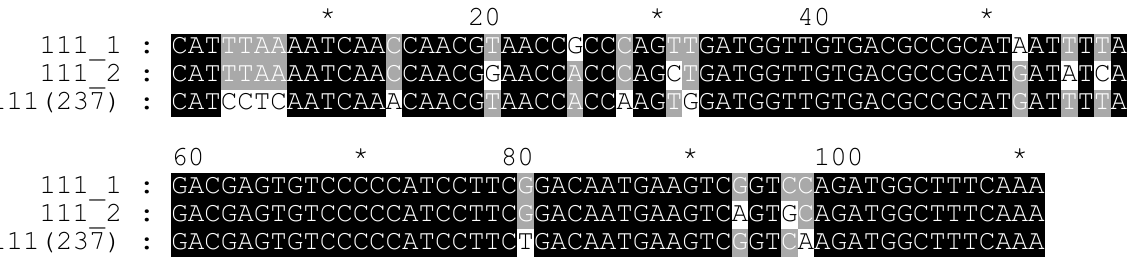
Figure 7. The alignment of long subunits of the delCS ‐ 237 monomers and 111 bp subunit of the CS ‐ 237 monomer.